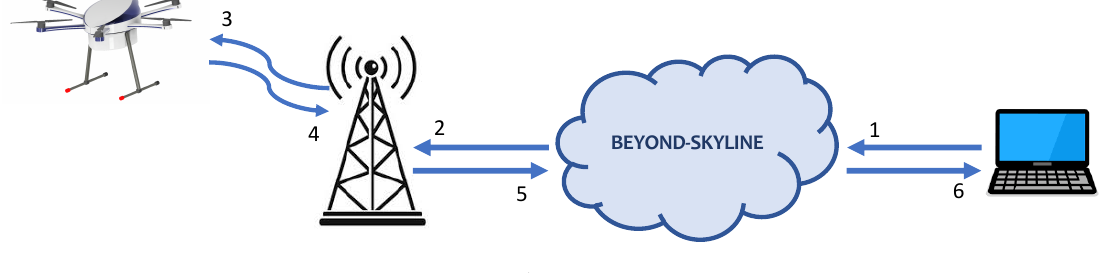
Figure 8. Round trip time tests